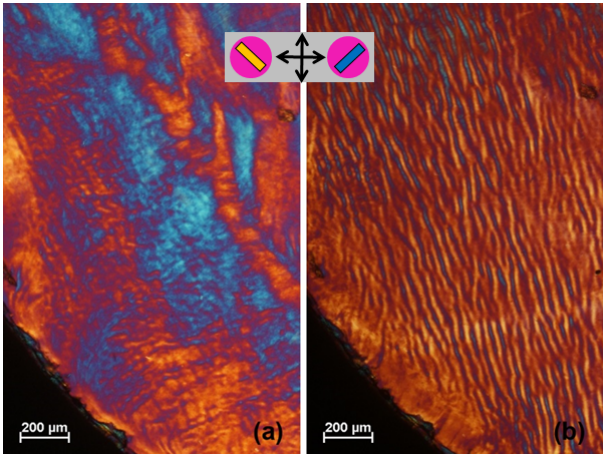
Figure 3. Effect of shear relaxation on texture of 6 wt % carboxyl stabilized CNC (cCNC) aqueous suspension, viewed by polarized light microscope between crossed polars with 530 nm red wave plate, oriented as in insert. ( a ) As initially prepared between microscope slide and cover glass; ( b ) after relaxing for 3 min after applying a left-to right shearing motion to cover glass.